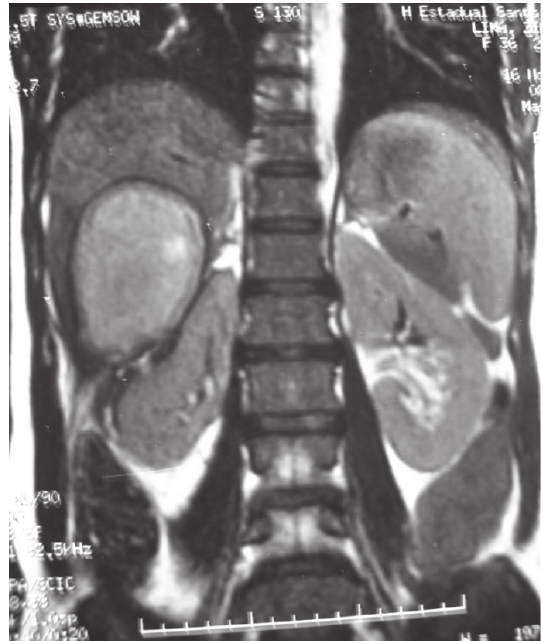
Figure 2 - Magnetic nuclear resonance image disclosing a 7.0-cm homogeneous mass in the segments V and VI of the liver, with peripheral enhancement of the wall after paramagnetic contrast injection, suggesting a hepatic abscess displacing the right kidney